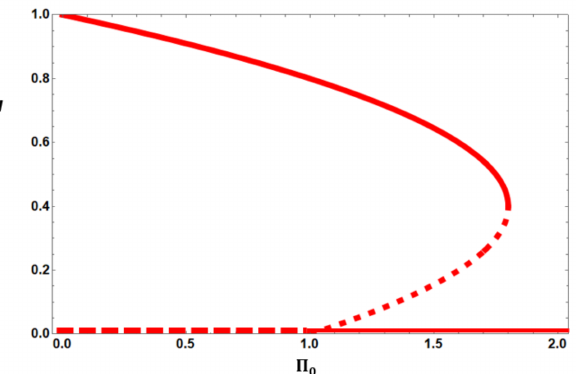
Figure 2. A bifurcation diagram linking steady state criminal activity levels to policing efficiency. The solid line corresponds to a stable steady state and the dashed line to an unstable steady state. In this case, with a = 0.2, we are considering low policing responsiveness to criminal activity. A saddle-node bifurcation is